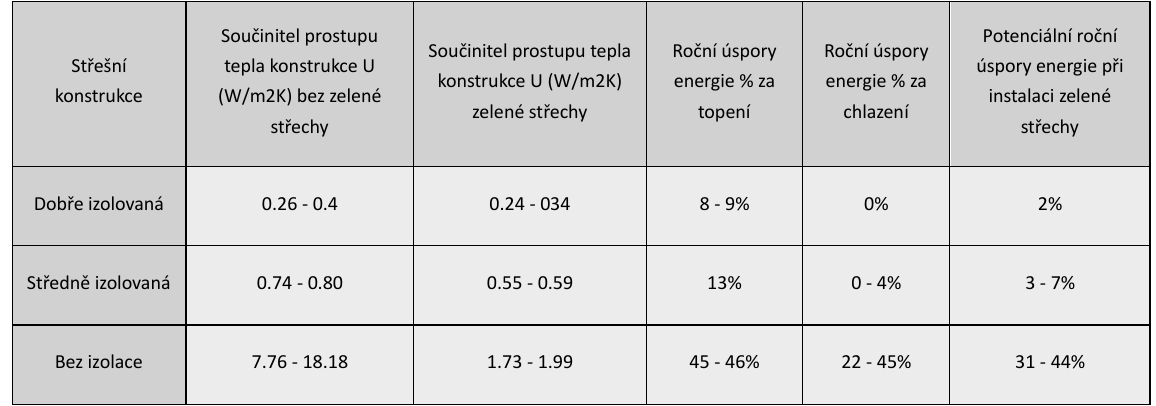
Tab. 1: Potenciální roční úspory energie při instalaci zelené střechy 1 , Nichaou et al. (2001)